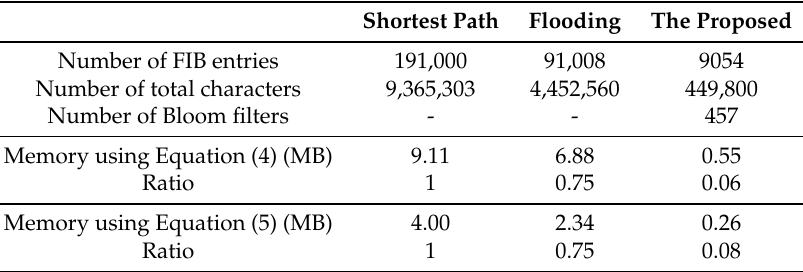
Table 4. Memory consumption of